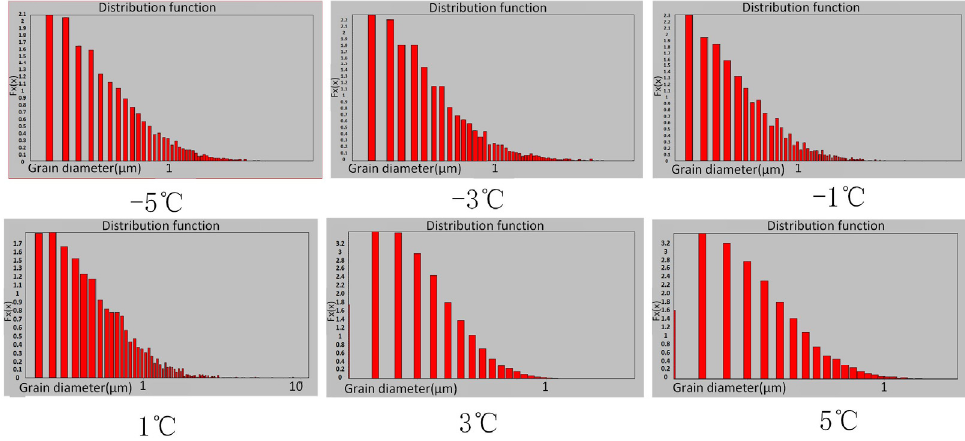
Figure 5. Distribution diagram of the corresponding grain size at di ff erent temperatures from − 5 °C to 5 °C. Compared to other temperatures, the grain size is smallest and most concentrated at 5 °C and 3